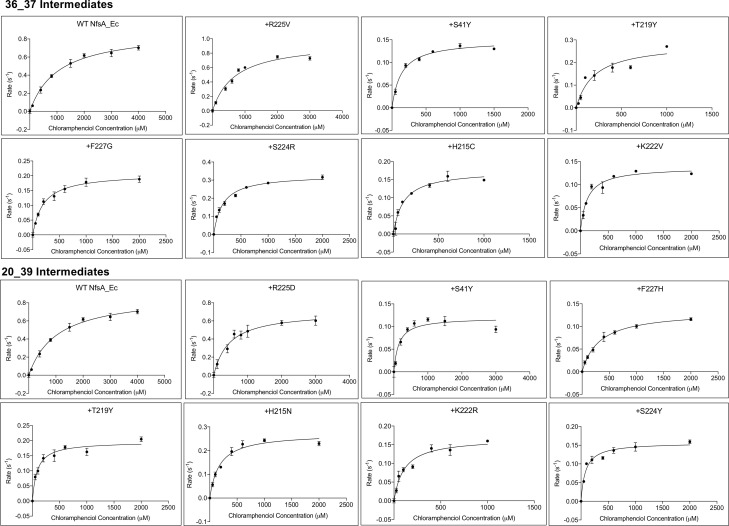
Michaelis-Menten plots of chloramphenicol reduction by NfsA enzyme intermediates derived from the most plausible hypothetical evolutionary trajectories for variants 36_37 and 20_39.Variant nomenclature is as per Figure 2F, such that each variant is described in terms of the additional substitutions that it bears relative to the one previous, as read left-to-right, row-by-row (e.g. 20_39 variant +H215N represents wild-type NfsA bearing the additional substitutions R225D, S41Y, F227H, T219Y, H215N). Reduction rates at varying chloramphenicol concentrations were measured at a fixed concentration of NADPH (250 µM). Chloramphenicol reduction was indirectly measured by monitoring the depletion of NADPH at 340 nm. Rates were calculated based on an extinction coefficient of 12,400 M- 1cm−1, reflecting the requirement for consumption of two molecules of NADPH per chloramphenicol reduced to the hydroxylamine form. Data presented is the average of three technical replicates ±1 S.D. Michaelis-Menten plots were generated using Graphpad 8.0.